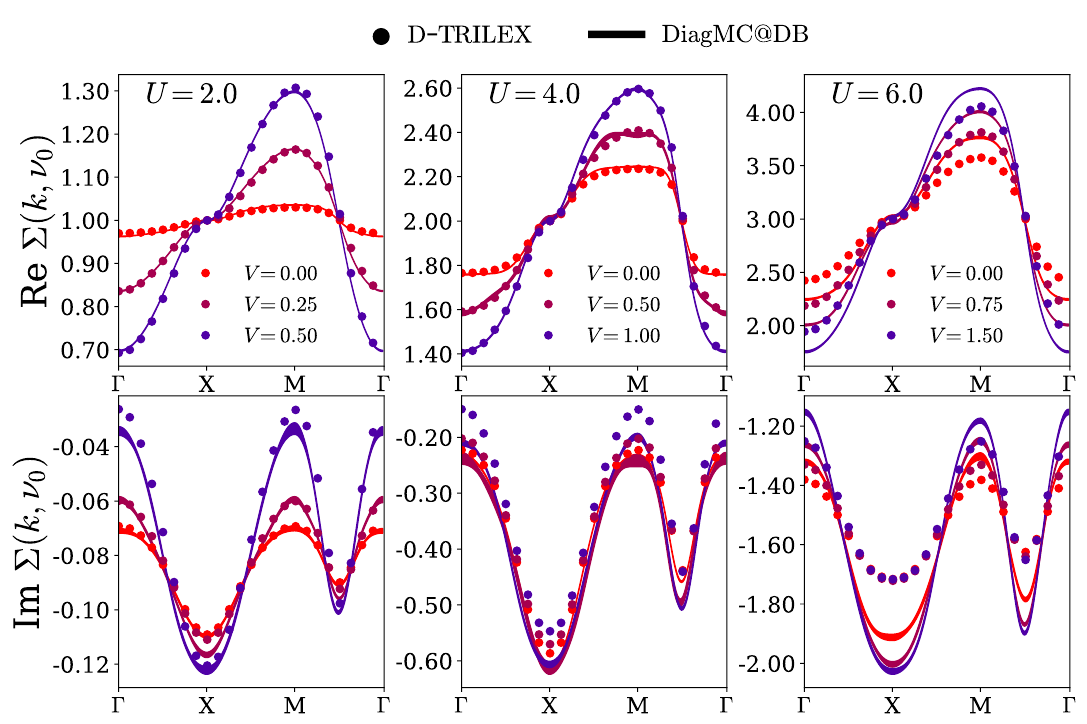
Figure 6: Real (top row) and imaginary (bottom row) parts of the lattice self-energy for the half-filled single-band extended Hubbard model on a square lattice. The result is obtained for U = 2.0 (left column), U = 4.0 (middle column), and U = 6.0 (right column) for three different values of the nearest-neighbor interaction V = 0.0 (light red), V = U / 8 (dark red), and V = U / 4 (purple). The D-TRILEX result is depicted by dots. The DiagMC@DB data is taken from Ref. [ 83 ] and is represented by solid lines with the width that corresponds to the estimated stochastic